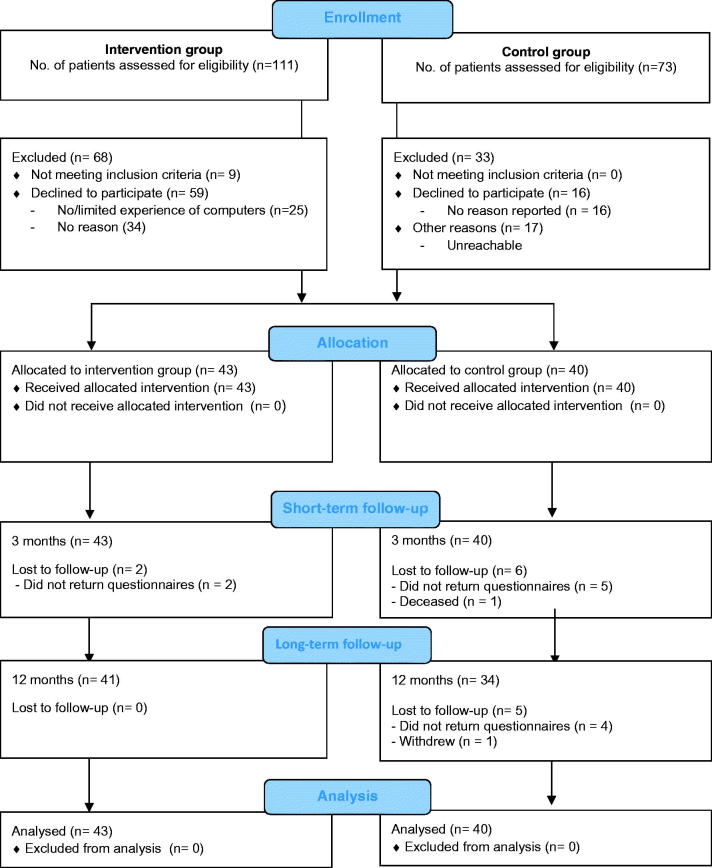
Flow of patients with COPD across the different stages of the trial.